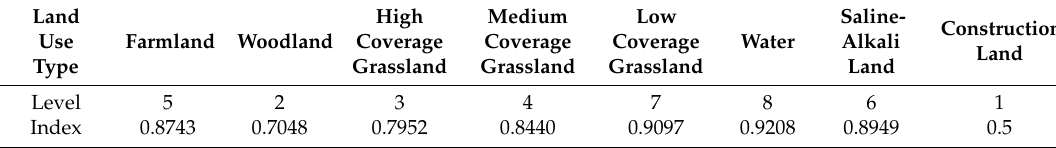
Table A2. Ecological vulnerability index of di ff erent land use